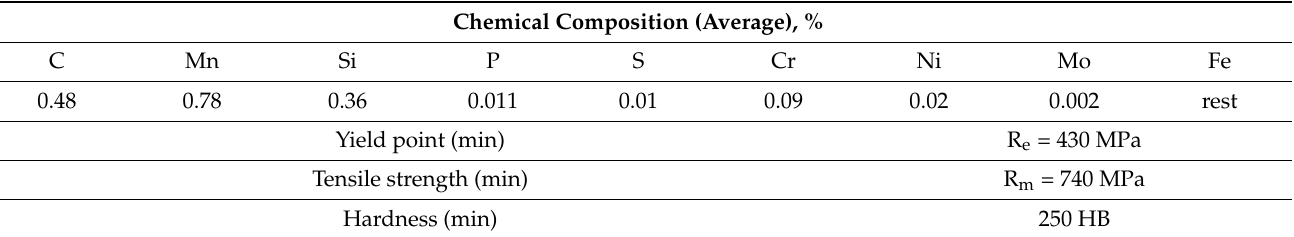
Table 1. Chemical composition and strength properties of C45